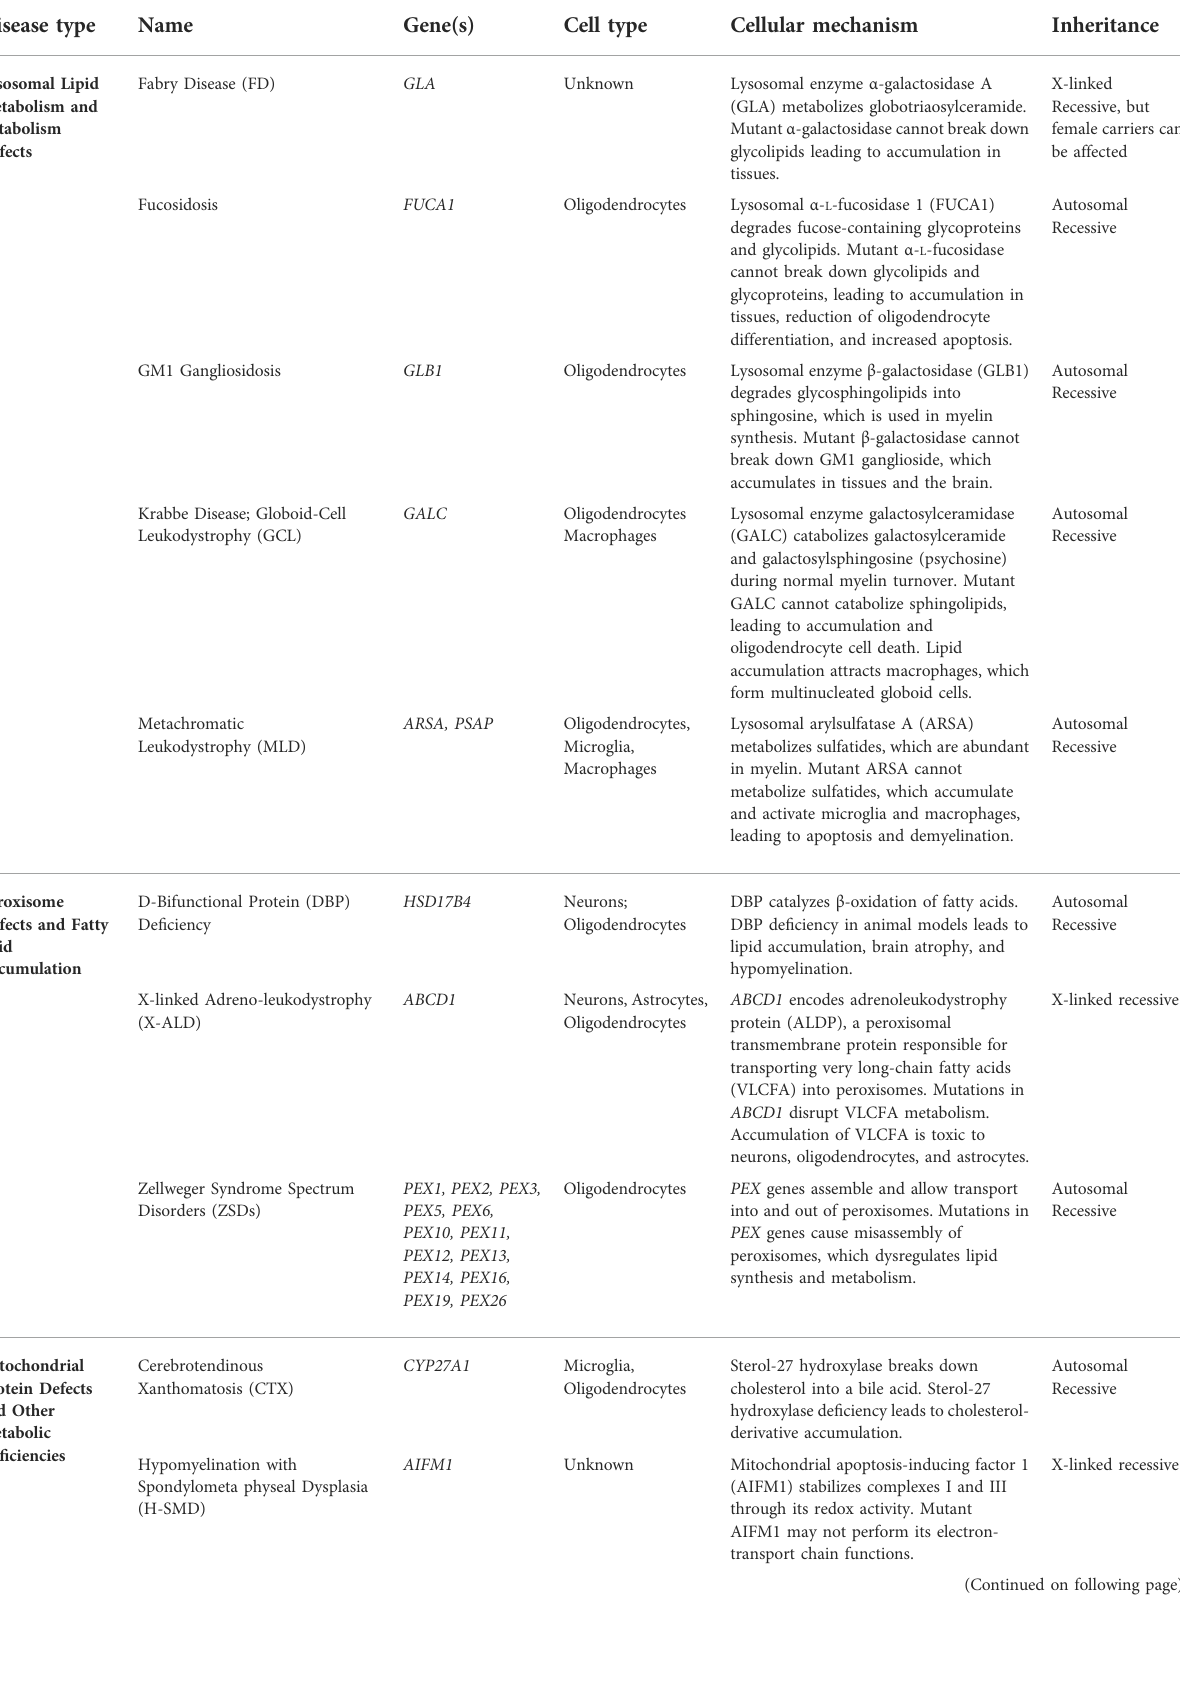
TABLE 1 Leukodystrophy-causing mutations and their cellular